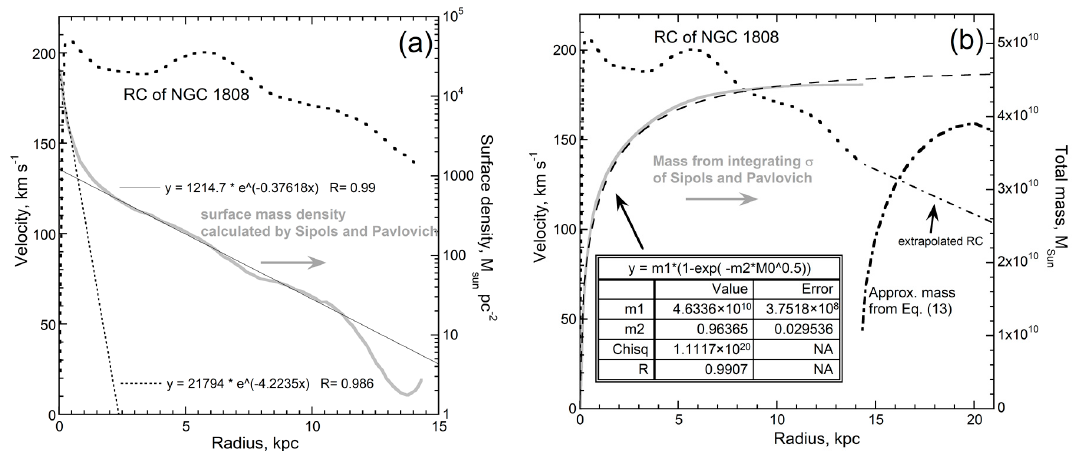
Figure 15. Inverse analysis of NGC 1808 by Sipols and Pavlovich [11], based on measured RC of Sofue et al. [81], shown as a heavy dotted line: ( a ) Results for σ from matrix inversion of (29) by [11]. Dashed line = least squares fit below 0.8 kpc. Thin line = fit from 2 to 12 kpc; ( b ) Mass obtained form (26), which integration smooths σ . Black dashed line = the least squares fit listed in the box. For comparison, mass was computed for a thin, constant density disk from (13) using extrapolated velocity (thin dash-dotted line). Equation (13) has a singularity in v at r = a , while merging with the point mass approximation at large r .